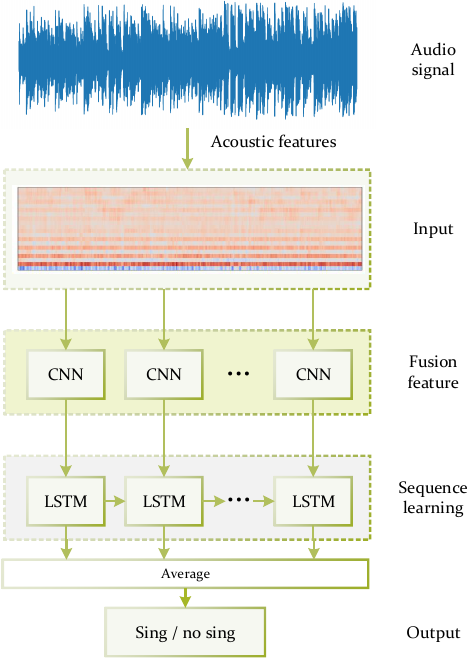
Figure 2. The topology of